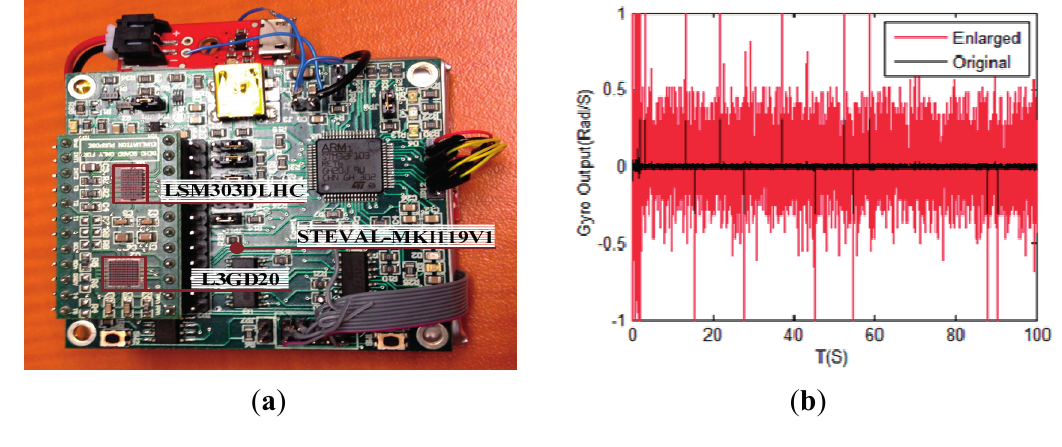
Figure 8. Photograph of the experimentation system and the recorded gyro